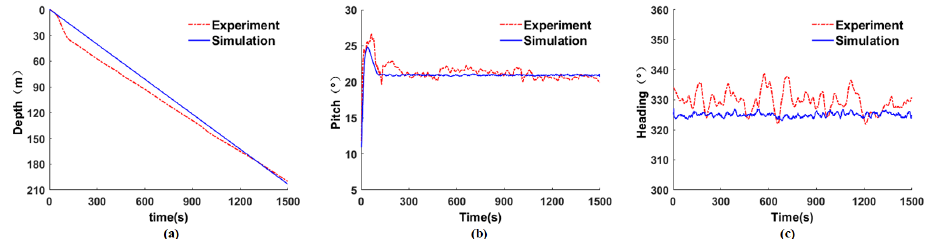
Figure 11. Comparison of experimental results and simulation results: ( a ) depth; ( b ) pitch; ( c )